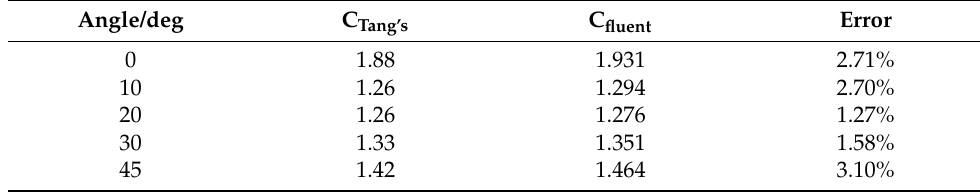
Table 2. Load coefficients calculated by Tang and